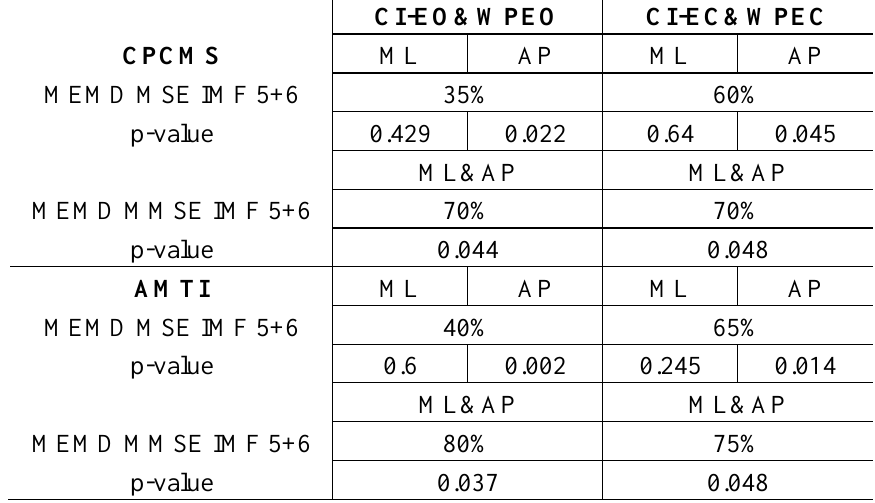
Table 8. Compare MEMD-Enhanced MSE and MEMD-Enhanced MMSE use IMF